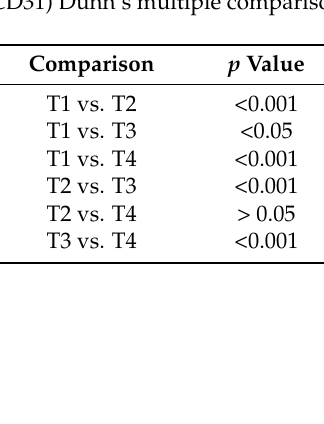
Table 10. MDV (CD31) Dunn’s multiple comparison between